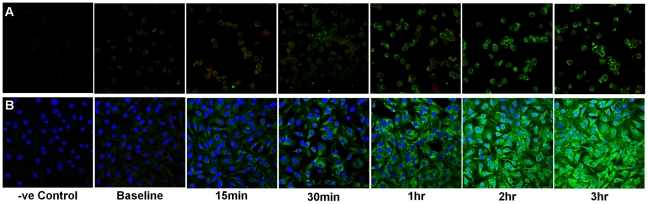
Effect of LPS on alveolar macrophage and ATII cell TLR-4 protein expression.Alveolar macrophages (A) and ATII cells (B) were exposed to LPS (100 ng/ml) over a three hour time course. Cells were fixed in methanol at 0, 15 mins, 30 mins, 1 hr, 2 hrs and 3 hrs and stained with FITC-labelled anti-TLR4 antibody. TLR4 expression was visualised using confocal microscopy. Images were taken through the centre of the cell to visualise cytosolic as well as cell surface expression. Data representative of 3 separate subjects.